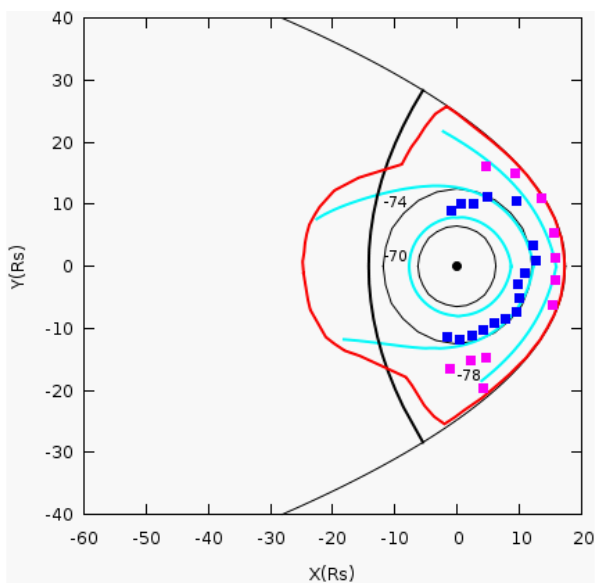
Fig. 6. Mappings of field lines into the KSM equatorial plane for image C with k s = 0 . 2. The boundaries of the dayside auroral oval corresponding to the red crosses shown in Fig. 2 are shown by the blue and purple squares for the equatorward and poleward bound- aries, respectively. The black lines show features of the magnetic model, where the outer curve shows the paraboloid magnetopause, the two inner circles centred on the planet (black dot) show the in- ner and outer boundaries of the equatorial ring current, while the black curve across the tail on the nightside indicates the inner edge of the tail current sheet. The pale blue lines show field lines cor- responding to fixed southern ionospheric latitudes of − 70 ◦ , − 74 ◦ , and − 78 ◦ as marked, while the red line corresponds to the boundary between open and closed field